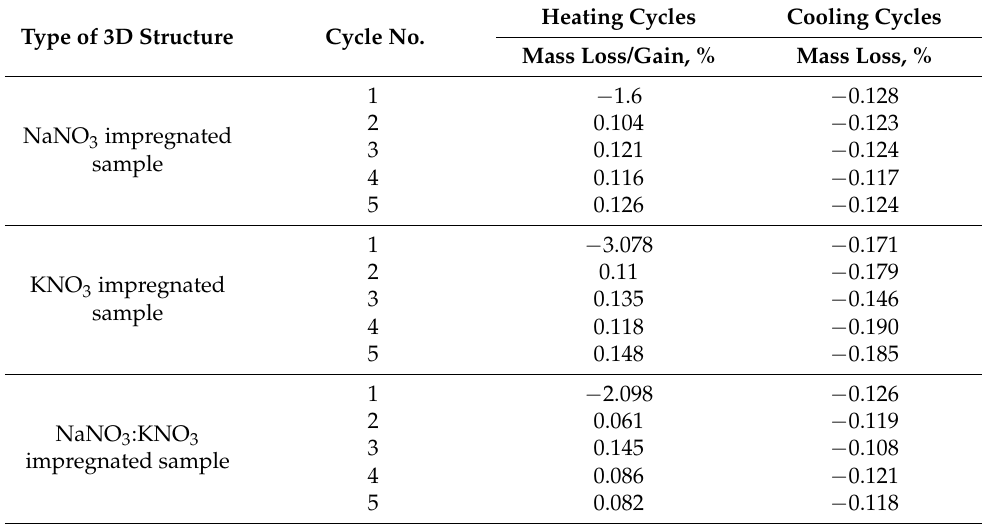
Table 4. Results of the thermogravimetric analysis for PCMs impregnated 3D structures. Type of 3D Structure